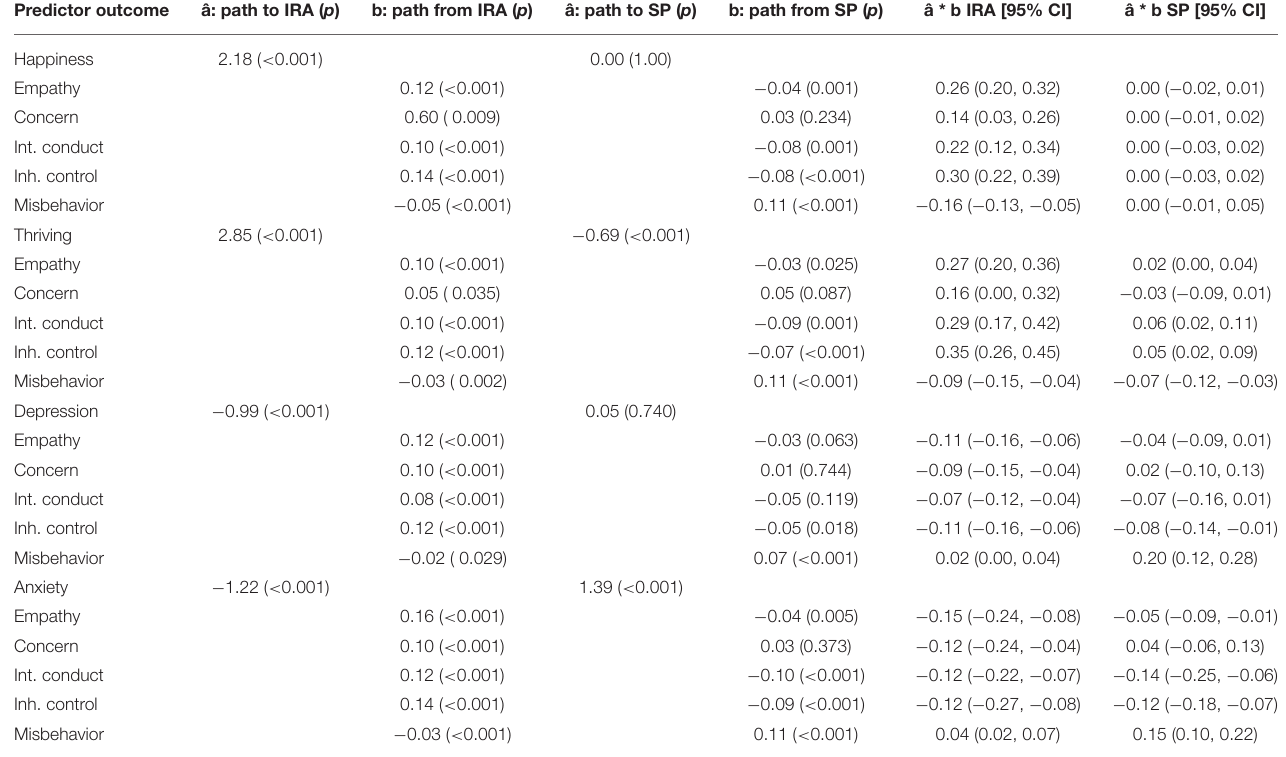
TABLE 4 | Study 1 (USA) summary of mediation effects. Predictor